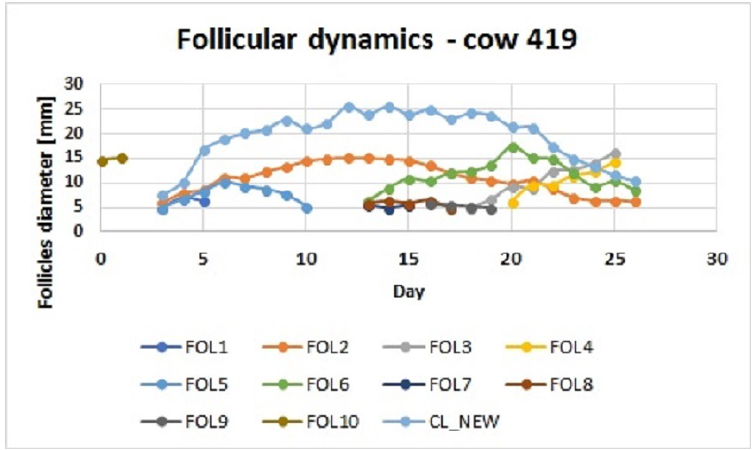
Figure 2. Follicular